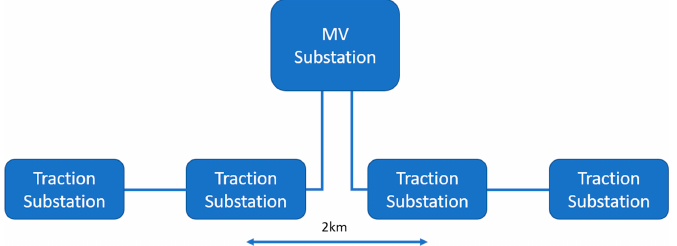
Figure 3. Illustration of the Inductive